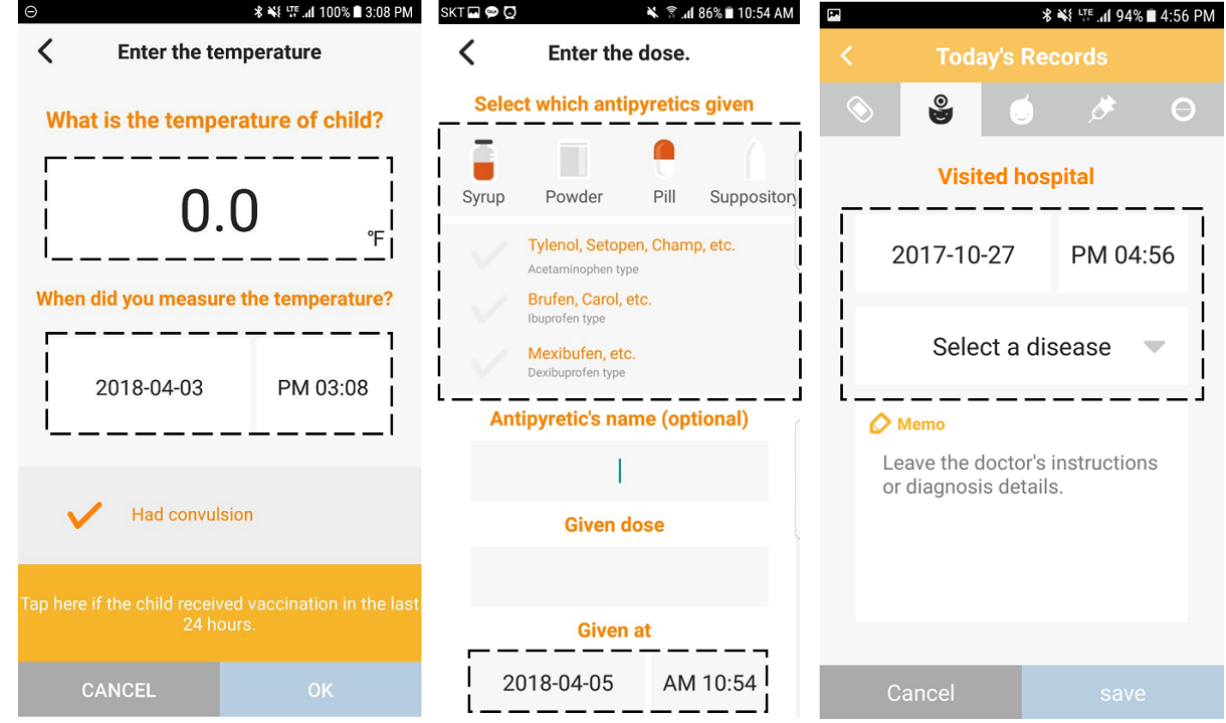
Figure 1. Antipyretic and temperature screens in the Fever Coach app: Enter the temperature (left), Enter the dose (center), Enter the diagnosis (right). The original app was in